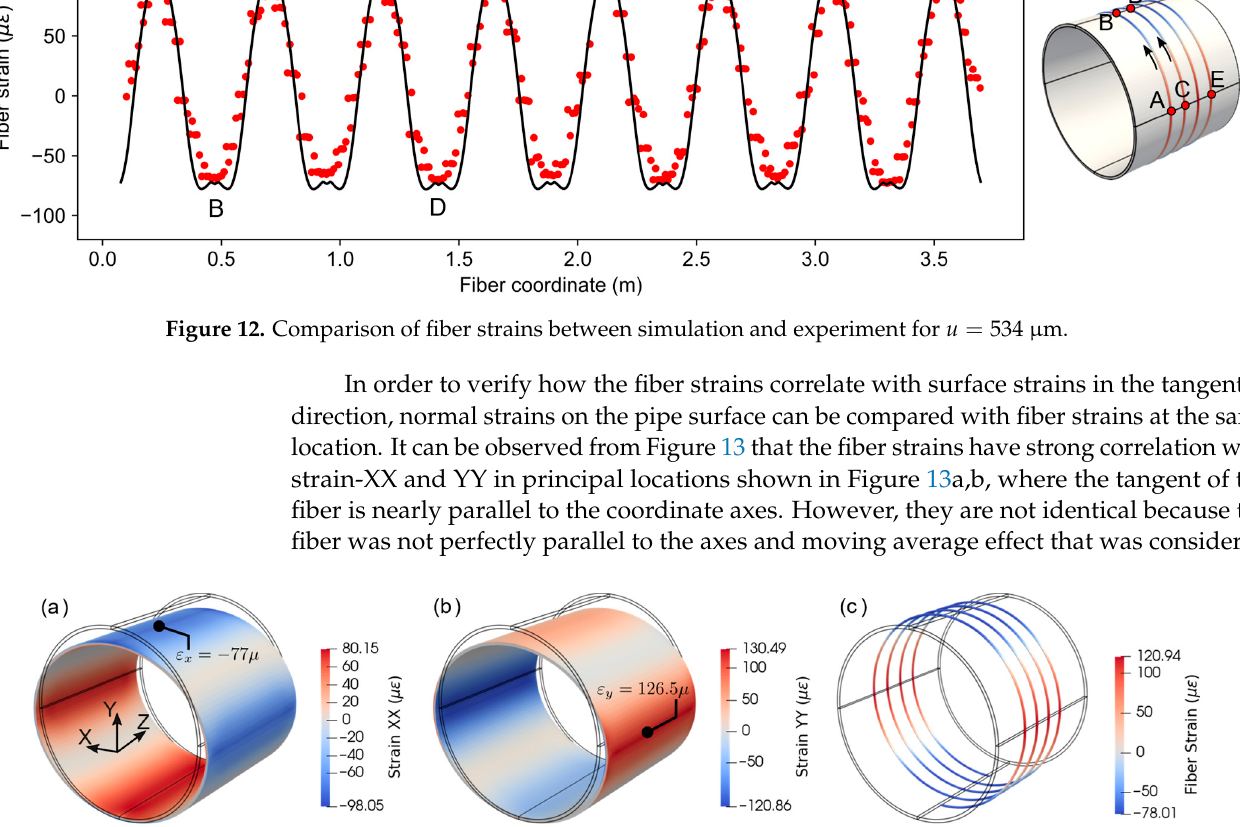
Figure 14. Comparison of fiber strains between simulation and experiment for (cid:1873) = 755(cid:2020)(cid:1865) 4. Estimation of Boundary Conditions Using Inverse IGA 4.1. Concept of Inverse IGA The results in the previous section showed that the simulation overpredicted fiber strains in the tensile side. The discrepancies can be attributed to different boundary con- ditions between experiment and simulation. This situation is not isolated to the current case; the boundary conditions are often unknown in real-world scenarios. However, the loading force is an important parameter for determining structural state and safety. Hence, a numerical method for estimating boundary conditions from the available fiber strain data is fruitful. The boundary conditions can be estimated by minimizing the error between ob- served fiber strains and simulated fiber strains using an optimization approach. This esti- mation of unknown variables (boundary conditions) from known experiment data (fiber strains) is termed as inverse IGA. The estimated boundary conditions can then be used in forward simulation to obtain displacement and stress distributions. It should be noted that an exact inverse is not possible since the fiber strain calculation using Equation (29) is irreversible. Previous studies have proposed the inverse method using least squares for plates [16], using inverse FEM (iFEM) for shells and plates [17] and, recently, using inverse IGA-iFEM for shells with strain gauge rosettes [36]. However, our formulations of inte- grated IGA and DFOS presented in Section 2 and the following inverse method are sub- stantially different since our method explicitly considers the geometry of the fiber and does not impose any restriction on the location or resolution of sampling points. 4.2. Estimation of Boundary Conditions for the Pipe Model In this section, the proposed method of inverse IGA is described by using the afore- mentioned pipe model as an illustrative example. The unknown loading along the pipe